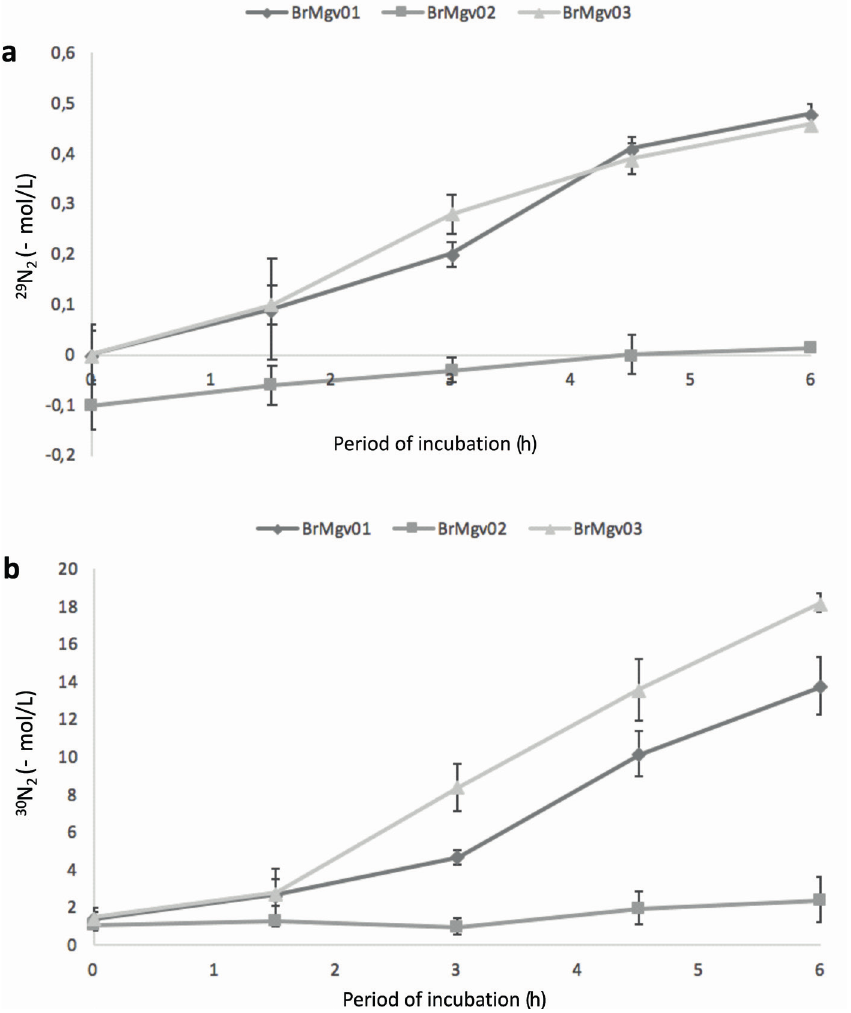
( a ) and 30 N ( b ) in the isotopic enrichment experiments of 2 2